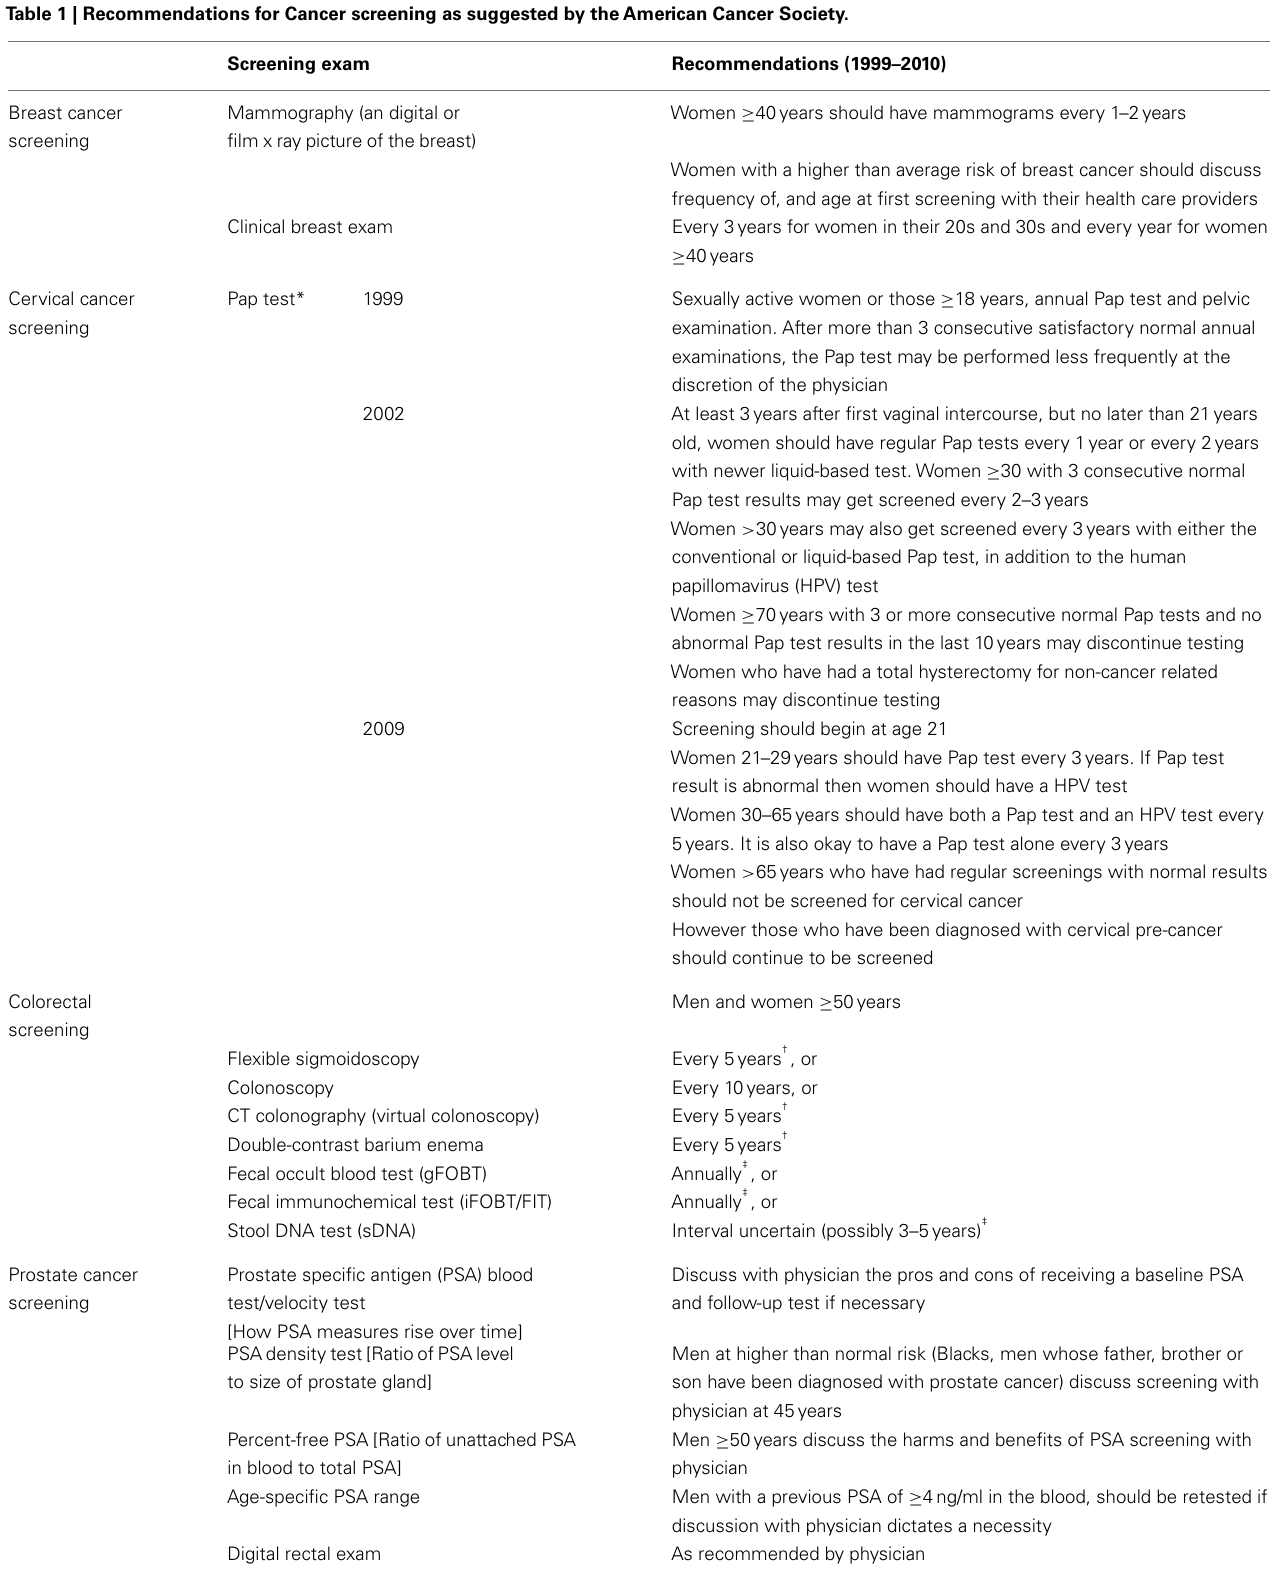
Table 1 | Recommendations for Cancer screening as suggested by theAmerican Cancer